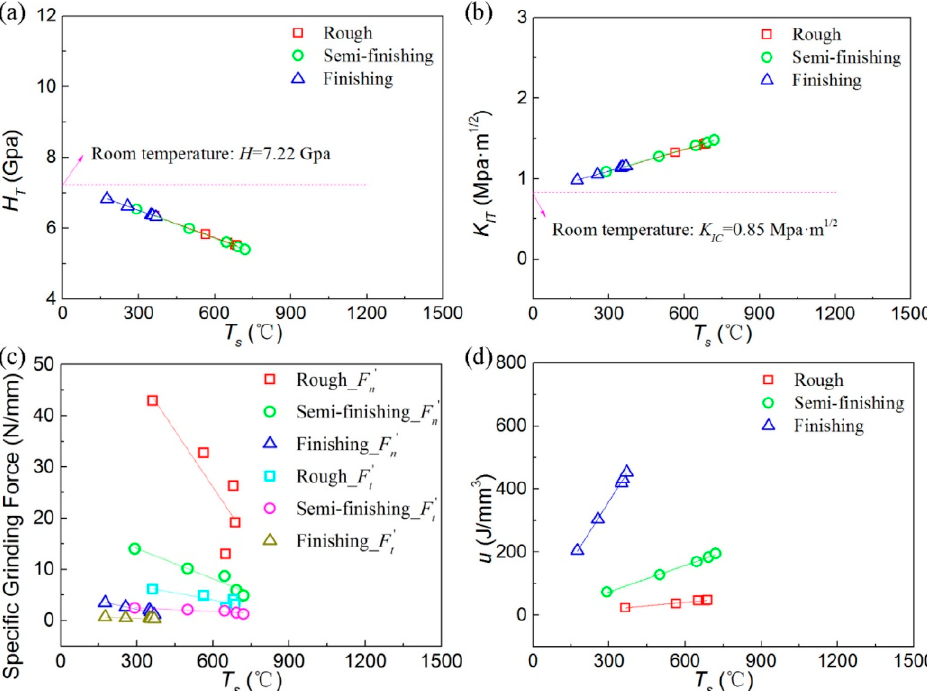
Figure 6. Effect of temperature on the single abrasive scratching of optical glass: ( a ) microhardness, ( b ) fracture toughness, ( c ) specific grinding force, ( d ) specific grinding energy [14].